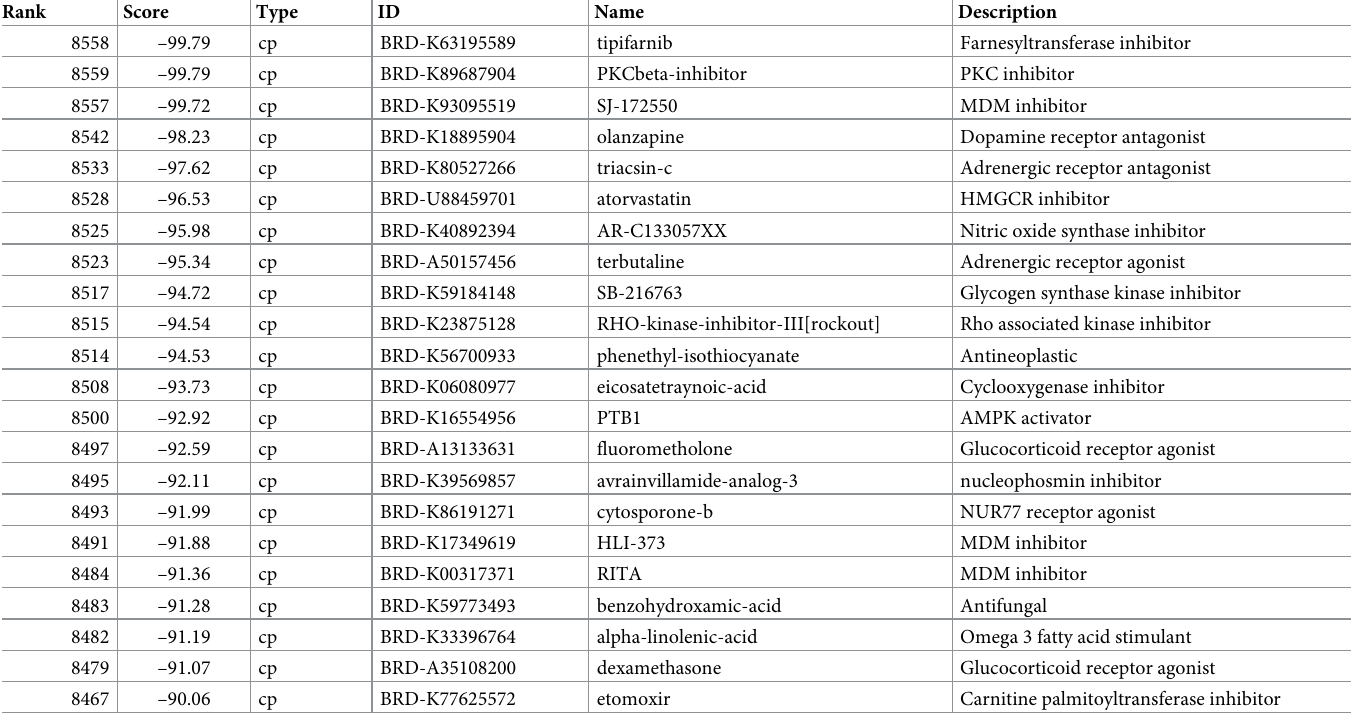
Table 1. Results of the CMap analysis. The compounds are classified according to their